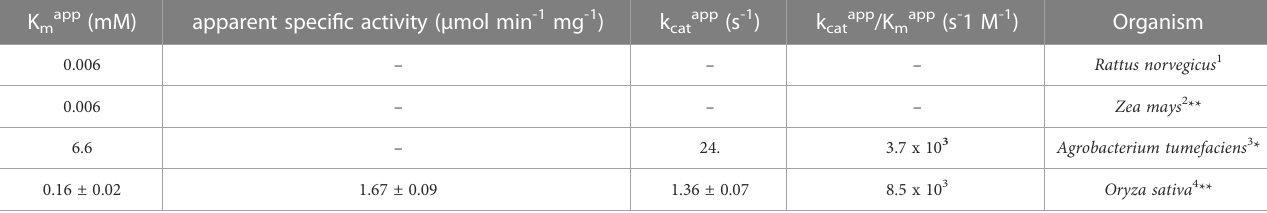
TABLE 5 Apparent kinetic parameters of ß-ureidopropionases from different organisms with the substrate ureidoisobutyric acid. K mapp